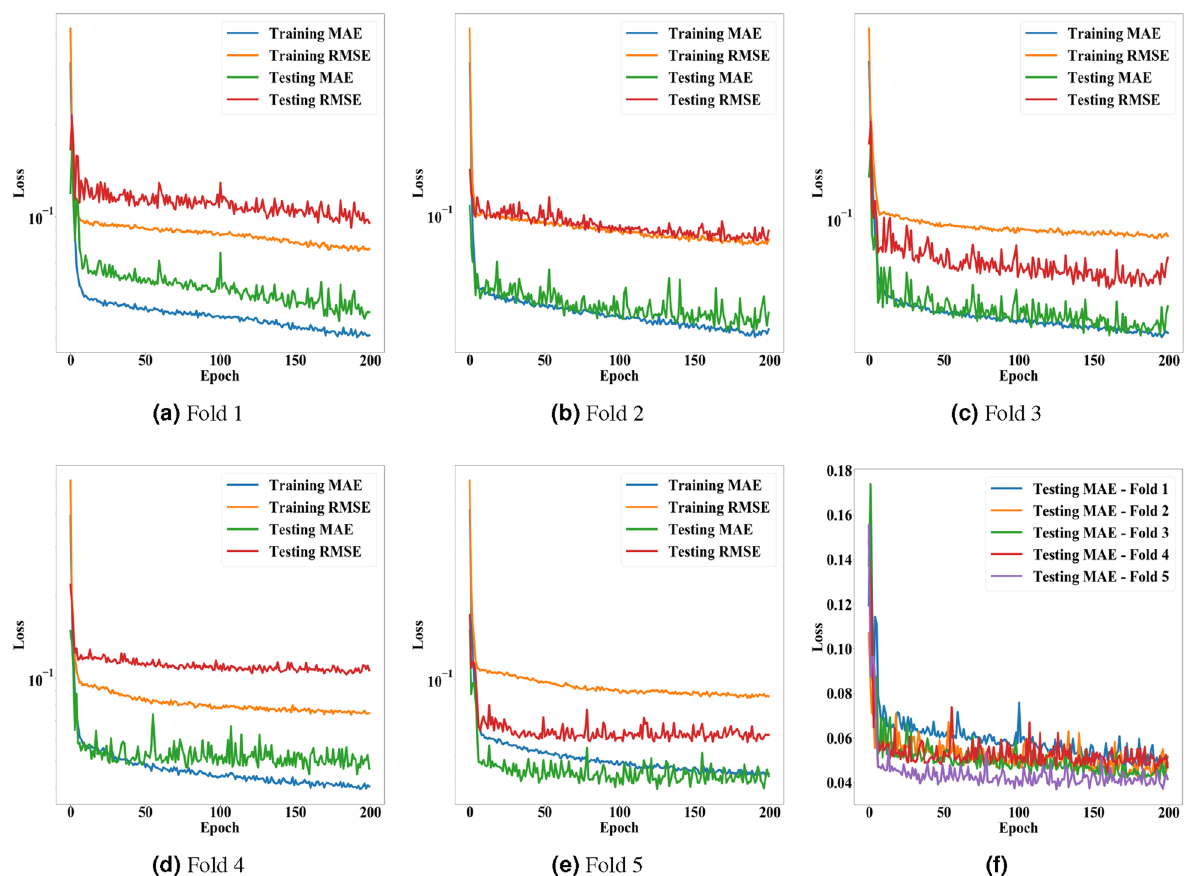
Figure 9. Accuracy of the proposed model for measuring changes in cell areas according to epochs. ( a – e ) present the MAE and RMSE of the proposed model on training and testing data from the first to fifth folds. ( f ) shows a comparison of the five folds with each other in terms of MAE.